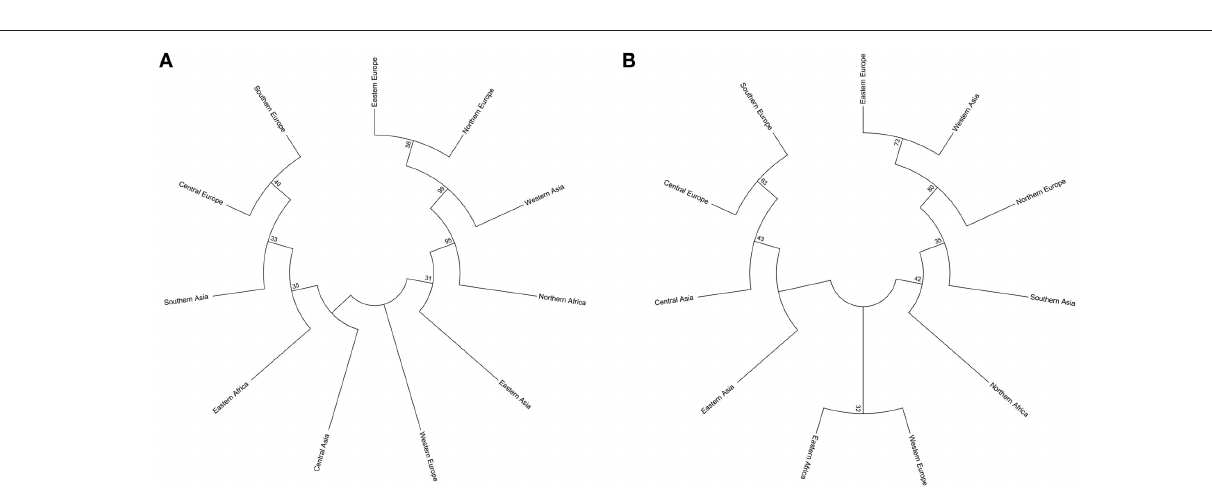
FIGURE 7 | Two bootstrap consensus trees showing the relationship of the geographic groups of the 43 grasspea accessions using 1,000 bootstraps. (A) Based on 87 SSR markers and (B) based on 42 SNP